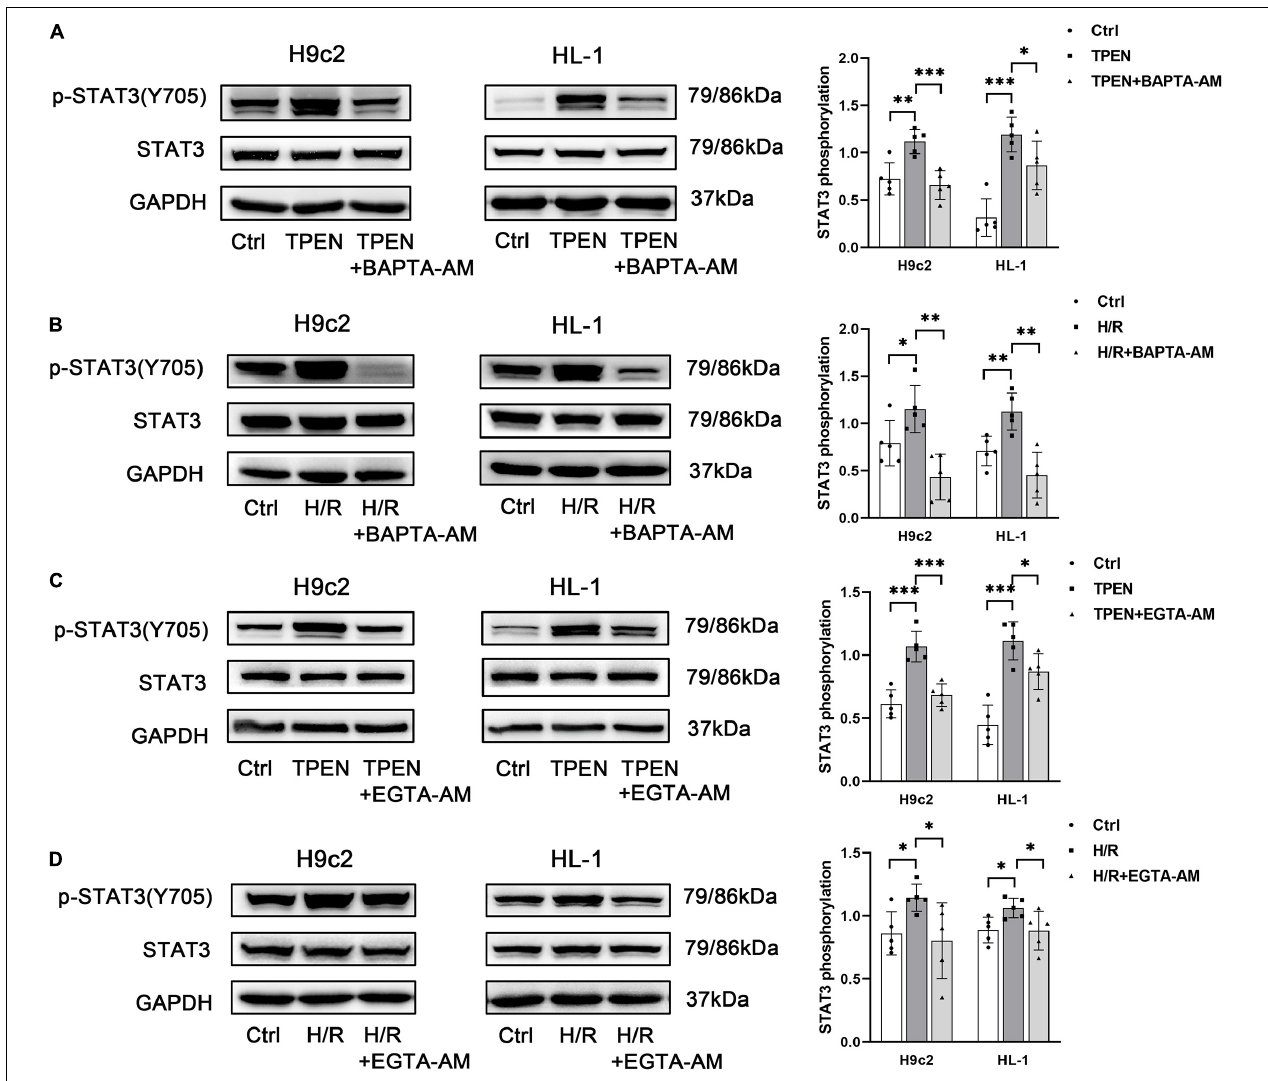
FIGURE 2 | Calcium is responsible for zinc deficiency-induced STAT3 activation. BAPTA-AM (10 µ M) (A,B) or EGTA-AM (10 µ M) (C,D) was applied 2 h before exposure to TPEN for 2 h or 30 min before the onset of reoxygenation ( n = 5). ∗ p < 0.05, ∗∗ p < 0.01, and ∗∗∗ p <